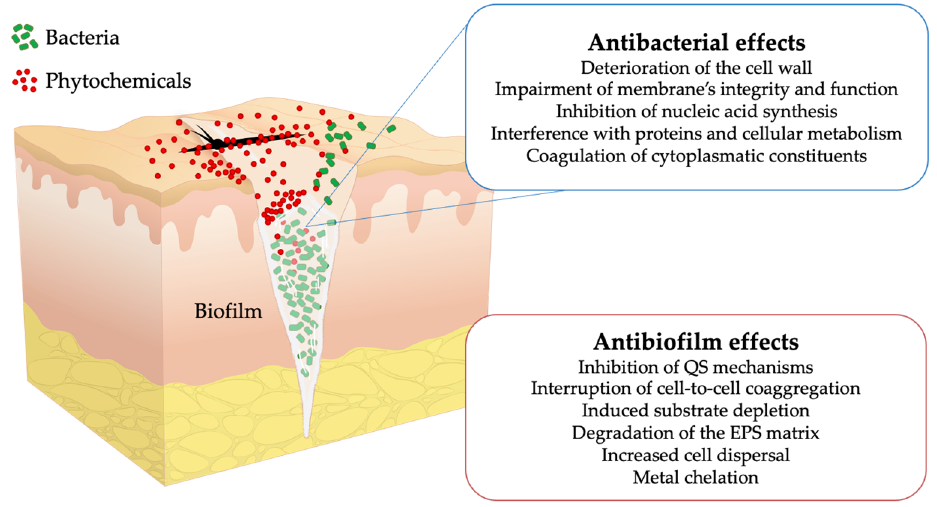
Figure 5. Illustration of an SSI and mode of action of phytochemicals against biofilms and their residing bacterial cells.